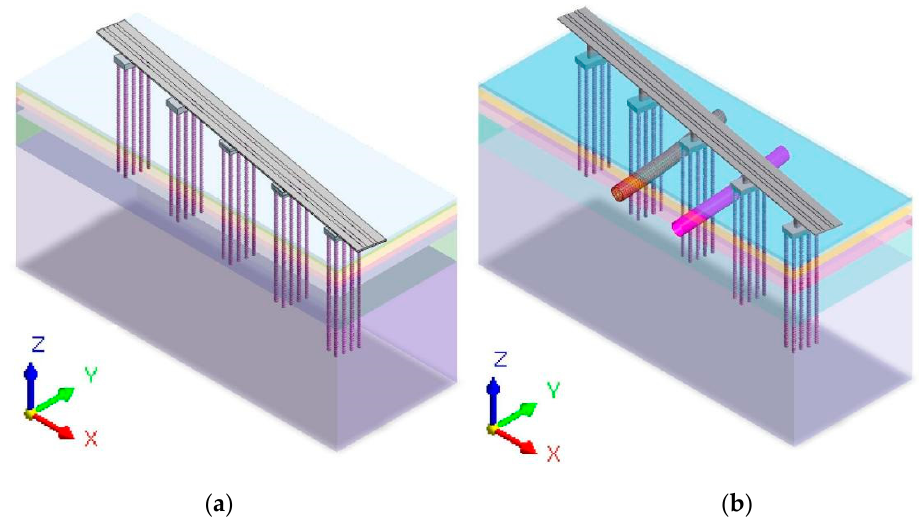
Figure 8. Numerical calculation models. ( a ) Pile-soil composite foundation. ( b ) Pile-soil composite foundation with adjacent tunnels. Table 3. Period of the main vibration. Table 2. Stratigraphy and main structural parameters.